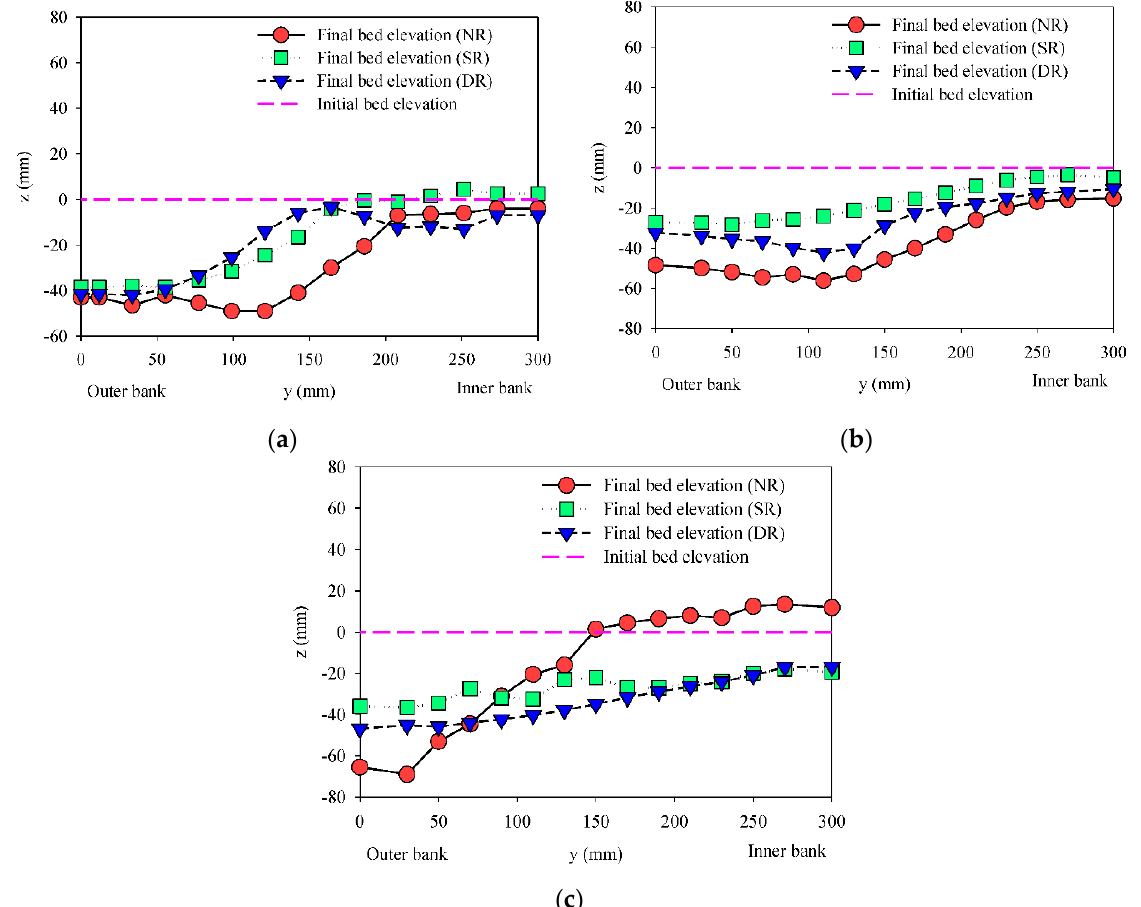
Figure 5. Bed elevations at the bend apex (cross-section C3): ( a ) Q = 10, ( b ) Q = 15 and ( c ) Q = 20 L/s.